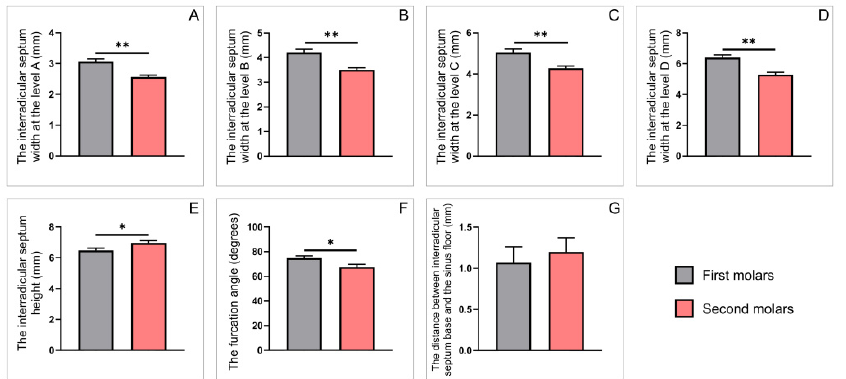
Figure 3. The parameters obtained on sagittal slices for all upper molars: ( A – D ) the interradicular septum width (in mm) at the levels A–D, respectively; ( E ) the interradicular septum height (in mm); ( F ) the interradicular furcation angle (in degrees); ( G ) the distance between interradicular septum base and the sinus floor (in mm). Values are expressed as the mean ± SEM. * Denotes a significant difference, p < 0.05; ** denotes a significant difference, p < 0.01.